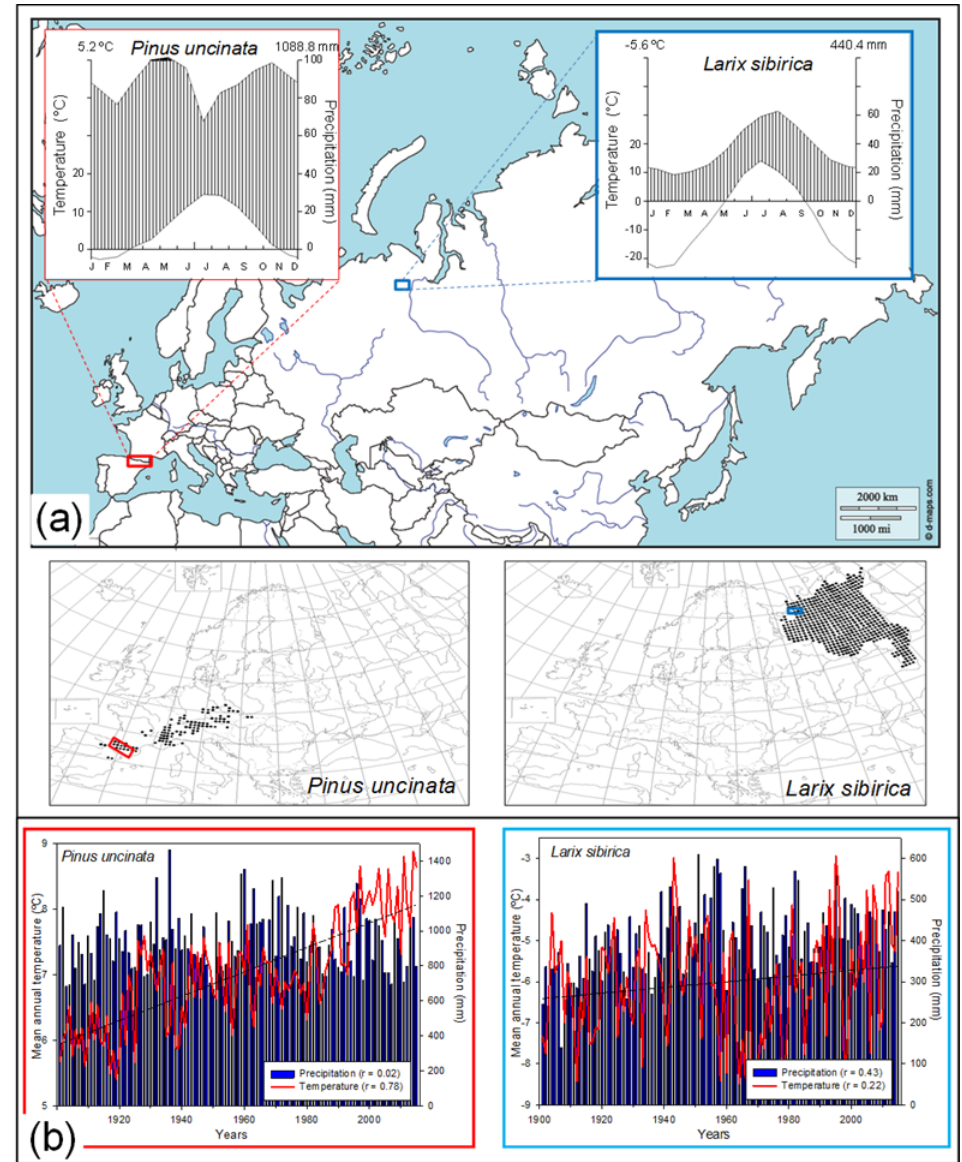
Figure 1. ( a ) Location of the sampled treelines in the Spanish Pyrenees ( Pinus uncinata Ram.) and in the Russian Polar Urals ( Larix sibirica Ledeb). The insets show the climatic diagram for each study site and below maps the distribution both species in Eurasia (Atlas Florae Europaeae). ( b ) Mean annual temperature and precipitation for the studied treelines during the 20th-century. The statistics show climatic trends (Pearson correlation coefficients, r) and the regression line for the temperature. Local, regional, and gridded data were used to build the climatic series (see [7]).